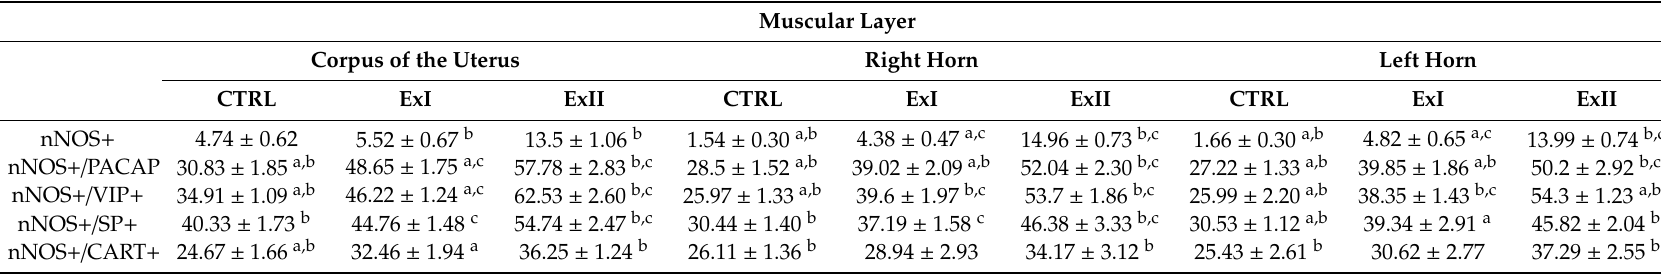
Table 1. The number of nNOS-positive fibers and their neurochemical characterization in the uterine corpus as well as in the rights and lefts horns in muscular layer of the control animals (CTRL) and pigs treated with low (E1) and high (E2) dose of bisphenol A.